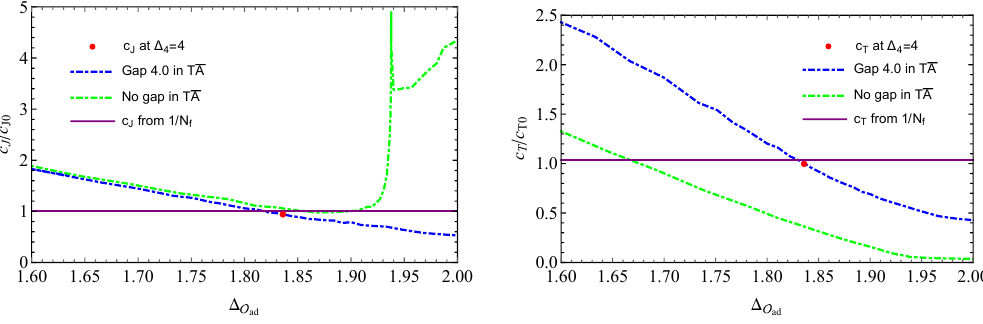
Figure 5 . Lower bounds on central charges c J (left panel) and c T (right panel) near the upper bounds on ∆ 4 with/without a gap ∆ ∗ = 4 in figure 4. The central charges are given with the 1 normalization in which c J = c T = 1 for N f = 20 two-component free fermions. The sharp pike in the c J lower bound without T ¯ A gap (green line in the left panel) can be affected by our sample points near the jump in ∆ 4 bound in figure 4. Clearly there is a jump in c J bound near ∆ O = 1 . 94 , ad but the shape of the bound right to the jump may change notably if our sample points get more close to the